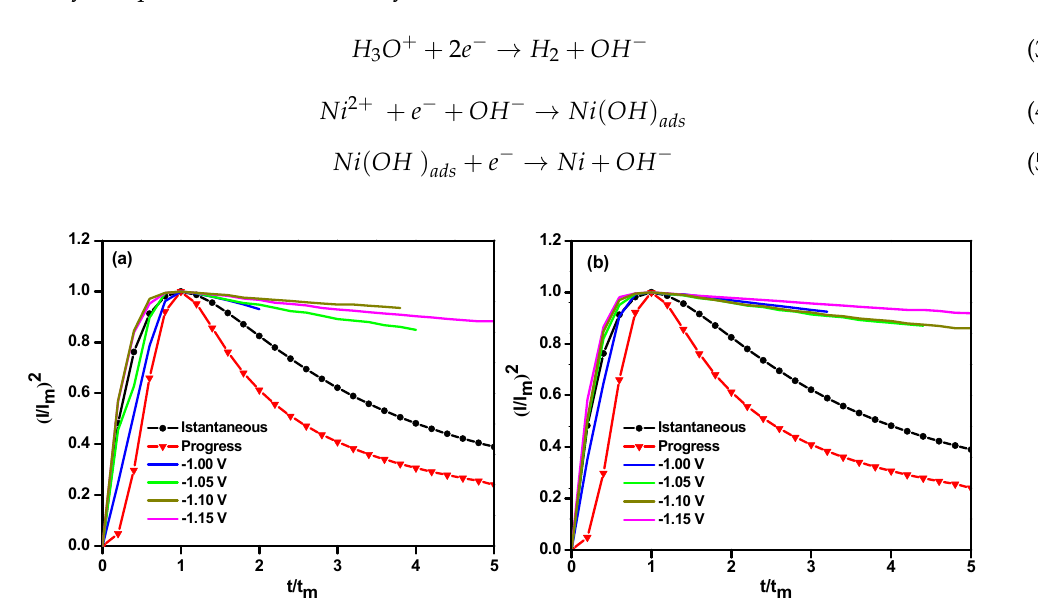
Figure 5. Non-dimensional curves for nickel and composite deposits: ( a ) Ni; and ( b ) Ni-Y 2 O 3 .